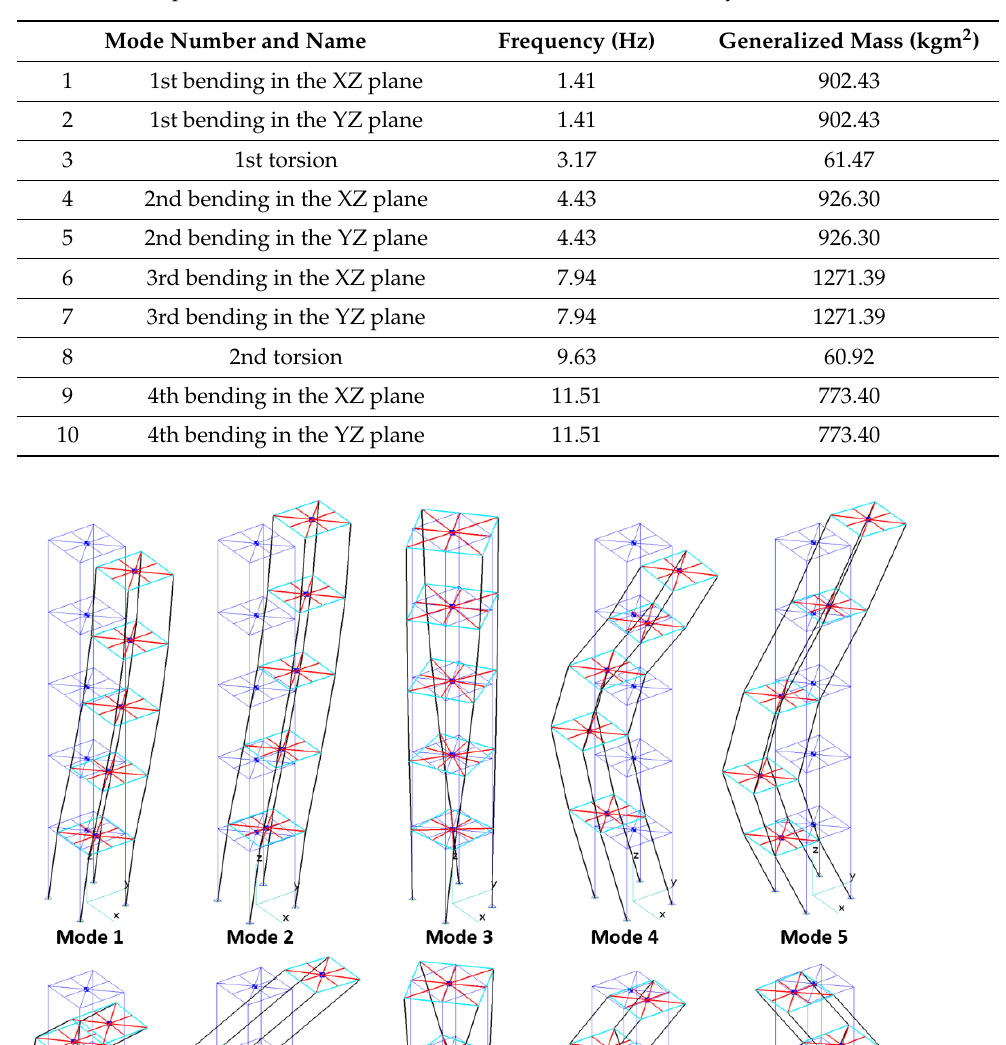
Table 2. Modal parameters of the reference structure (first 10 modes only).